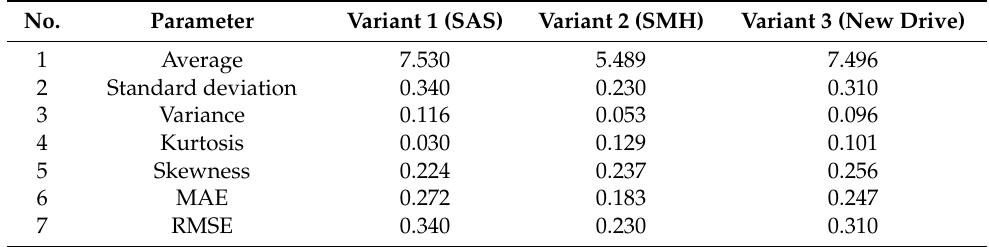
Table 3. Statistical description and errors of specific electric energy for each of the analyzed drives, obtained in Monte Carlo